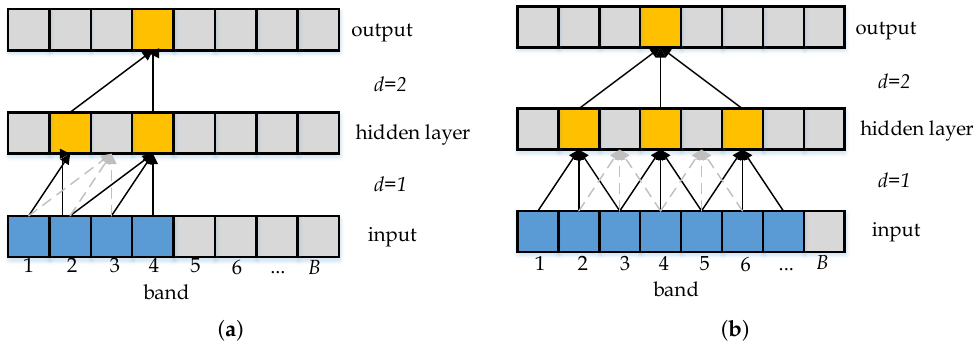
Figure 4. ( a ) An example of causal dilated convolutions, where the convolution output of a certain band does not depend on the information of the next bands and ( b ) an example of acausal dilated convolution, where the convolution output of a certain band depends on the information of the adjacent